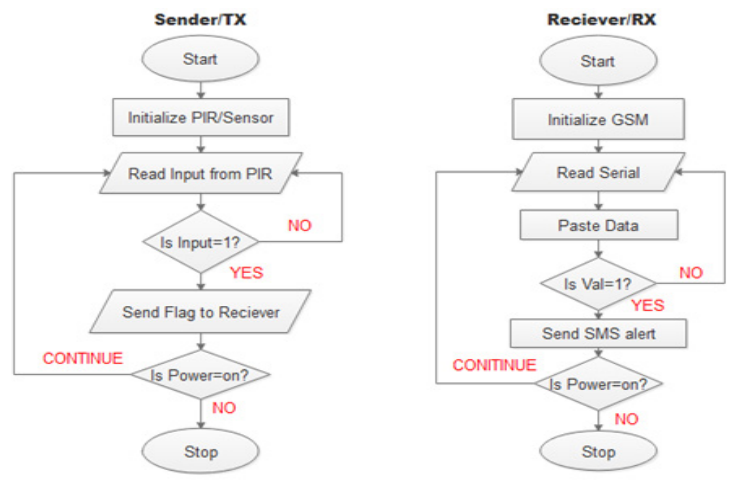
Fig. 3. Proposed Algorithm of the e-perimeter using the PIR and Wireless Radio Communica- tion module